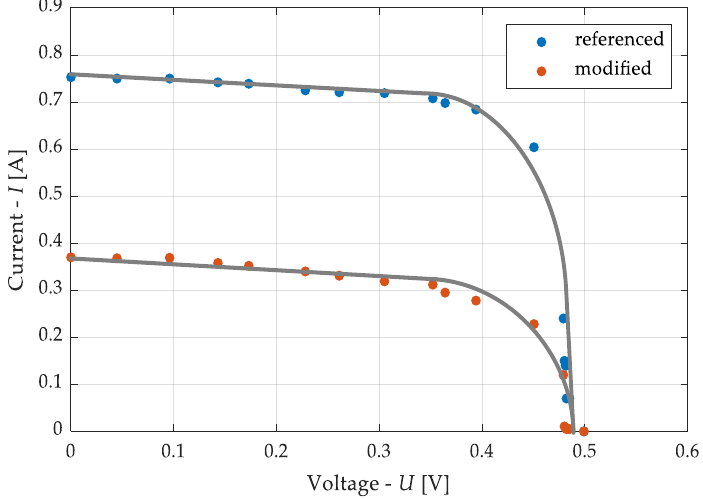
Figure 8. The current-voltage characteristic of reference photovoltaic cell and the modified photovoltaic cell (the great circle).